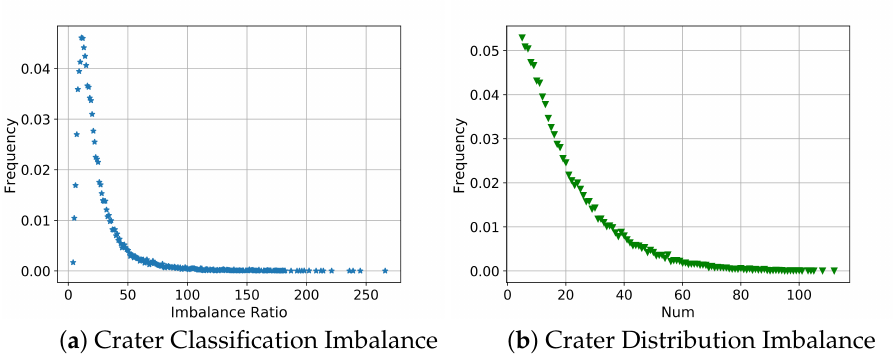
Figure 6. Data distribution statistics of impact craters. We randomly generated 30,000 crater training images to show the imbalanced distribution. ( a ) is the crater image classification imbalance, the x-axis is the data imbalance ratio (IR) [45], and the y-axis denotes the frequency distribution of the IR. ( b ) shows the distribution imbalance ratio (DR) of the craters, the x-axis denotes the number of craters in each training image, and the y-axis represents the frequency distribution of the crater number in the DEM